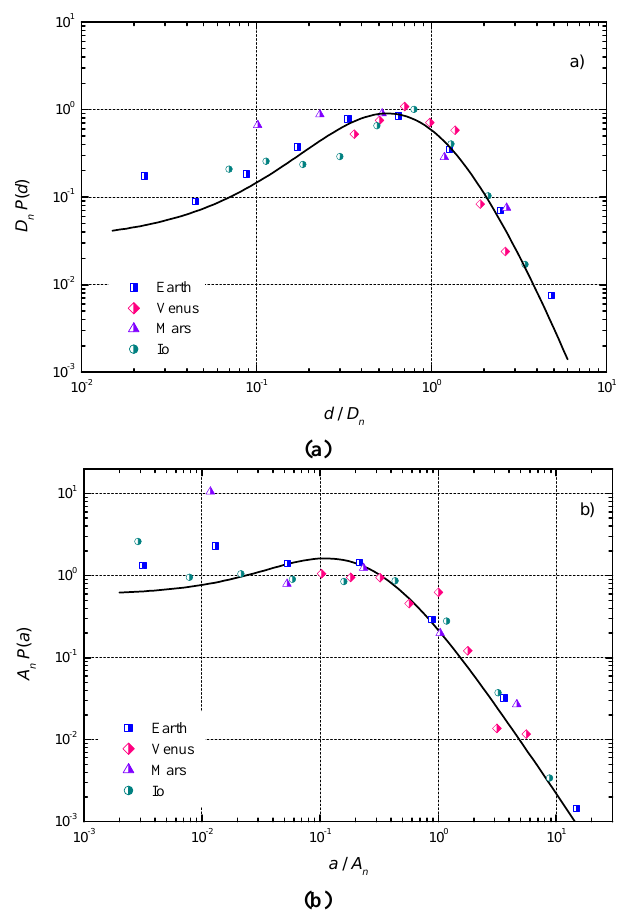
Fig. 2. Rescaled caldera/paterae distributions for Earth, Mars, Venus and Io according to Eq. (1): (a) rescaled diameters, with the mean diameter D n computed for each planetary body (Table 1). The solid curve is a fit to the rescaled distributions and is given by the GEV distribution, Eq. (2), with θ = 0 . 22 ± 0 . 06, µ = 0 . 64 ± 0 . 04, and σ = 0 . 42 ± 0 . 03; (b) rescaled areas, with the mean area A n computed for each planetary body (Table 1). The solid curve is a fit to the rescaled distributions and is given by the GEV distribution, Eq. (2), with θ = 0 . 84 ± 0 . 11, µ = 0 . 26 ± 0 . 03, and σ = 0 . 30 ± 0 . 03.